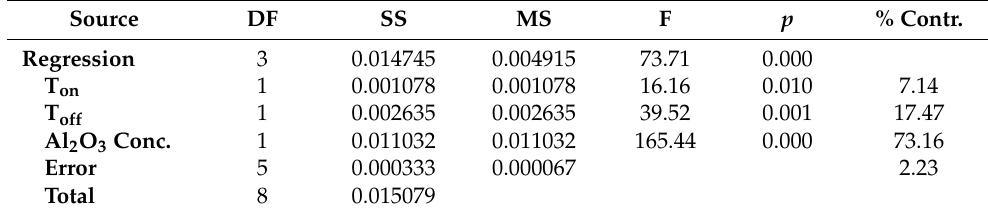
Table 3. ANOVA for MRR.